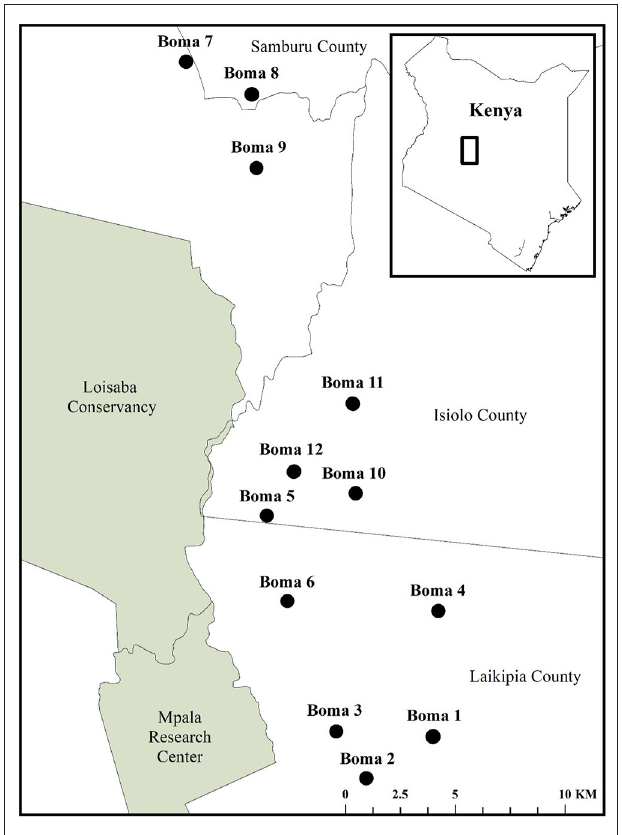
FIGURE 2 | The location of 12 bomas equipped with the motion-activated cameras in Central Kenya to detect carnivore species encountering livestock from September, 2018 to May, 2019.